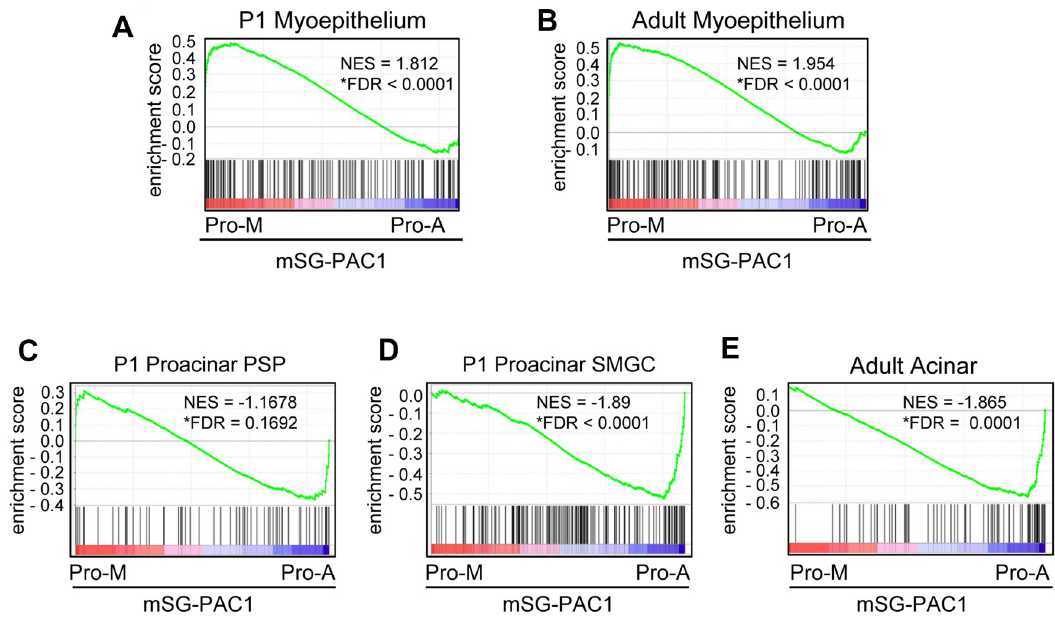
Fig 2. The culture of mSG-PAC1 spheroids in Pro-M or Pro-A results in the expression of myoepithelial or acinar enriched genes respectively. GSEA using scRNA-seq gene-sets generated from murine SMG from P1 pups or adult mice [37] showed murine myoepithelial gene upregulation in Pro-M medium and murine acinar gene upregulation in Pro-A medium. (A, B) myoepithelial cells from P1 and adult mice, (C, D) pro-acinar cells from the Smgc and PSP clusters from P1, and (E) acinar cells from adult mice. NES = Normalized Enrichment Score and FDR = False Discovery Rate. � FDR q-value < 0.25 represent significant